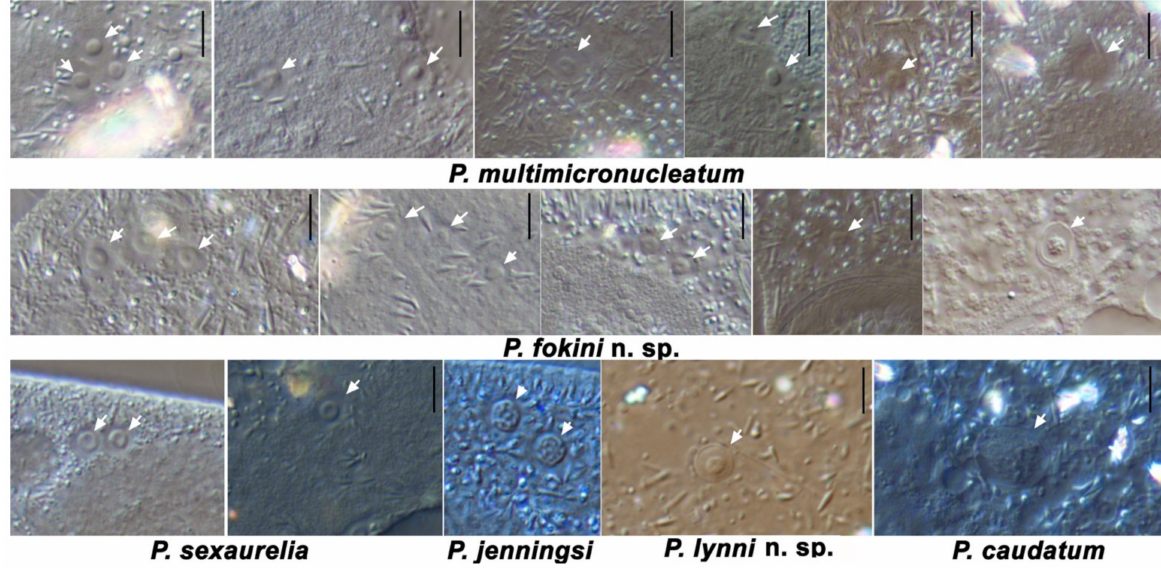
Figure 6. Variability in micronuclei shape and appearance of several Paramecium s. str. subgenus species. DIC microscopy. Micronuclei are marked with the arrows. Scale bar is 4 µ